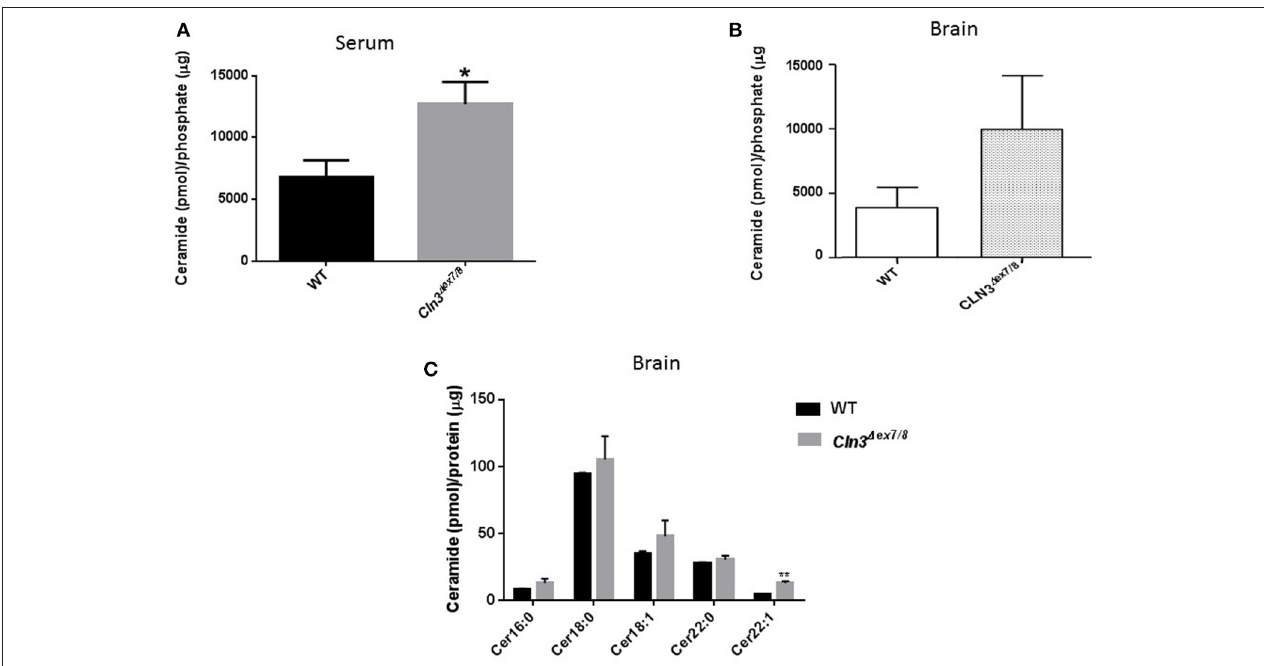
FIGURE 1 | (A) Serum ceramide levels by DGK assay in age-matched WT and Cln3 ∆ ex7/8 mice (16, 24, and 48 weeks). Serum ceramide levels in Cln3 ∆ ex7/8 mice ( n = 12) were significantly higher compared to age-matched WT mice ( n = 7) (* P < 0.05). (B) Brain ceramide levels were determined by DGK assay in 17 weeks-old age-matched WT and Cln3 ∆ ex7/8 mice ( n = 4 in each group). Brain ceramide levels in Cln3 ∆ ex7/8 mice were higher compared to age-matched WT mice. (C) Ceramide subspecies were characterized by LC-MS in 44 weeks-old age-matched WT and Cln3 ∆ ex7/8 mice ( n = 4 in each group). Cer16, Cer18, Cer18:1, Cer22, and Cer22:1 were the major species identified in WT mouse brain, with Cer18 being the predominant ceramide fatty acid. In age-matched Cln3 ∆ ex7 / 8 mice, corresponding ceramide fatty acids had higher levels, with the difference statistically significant for Cer22:1 (** P <